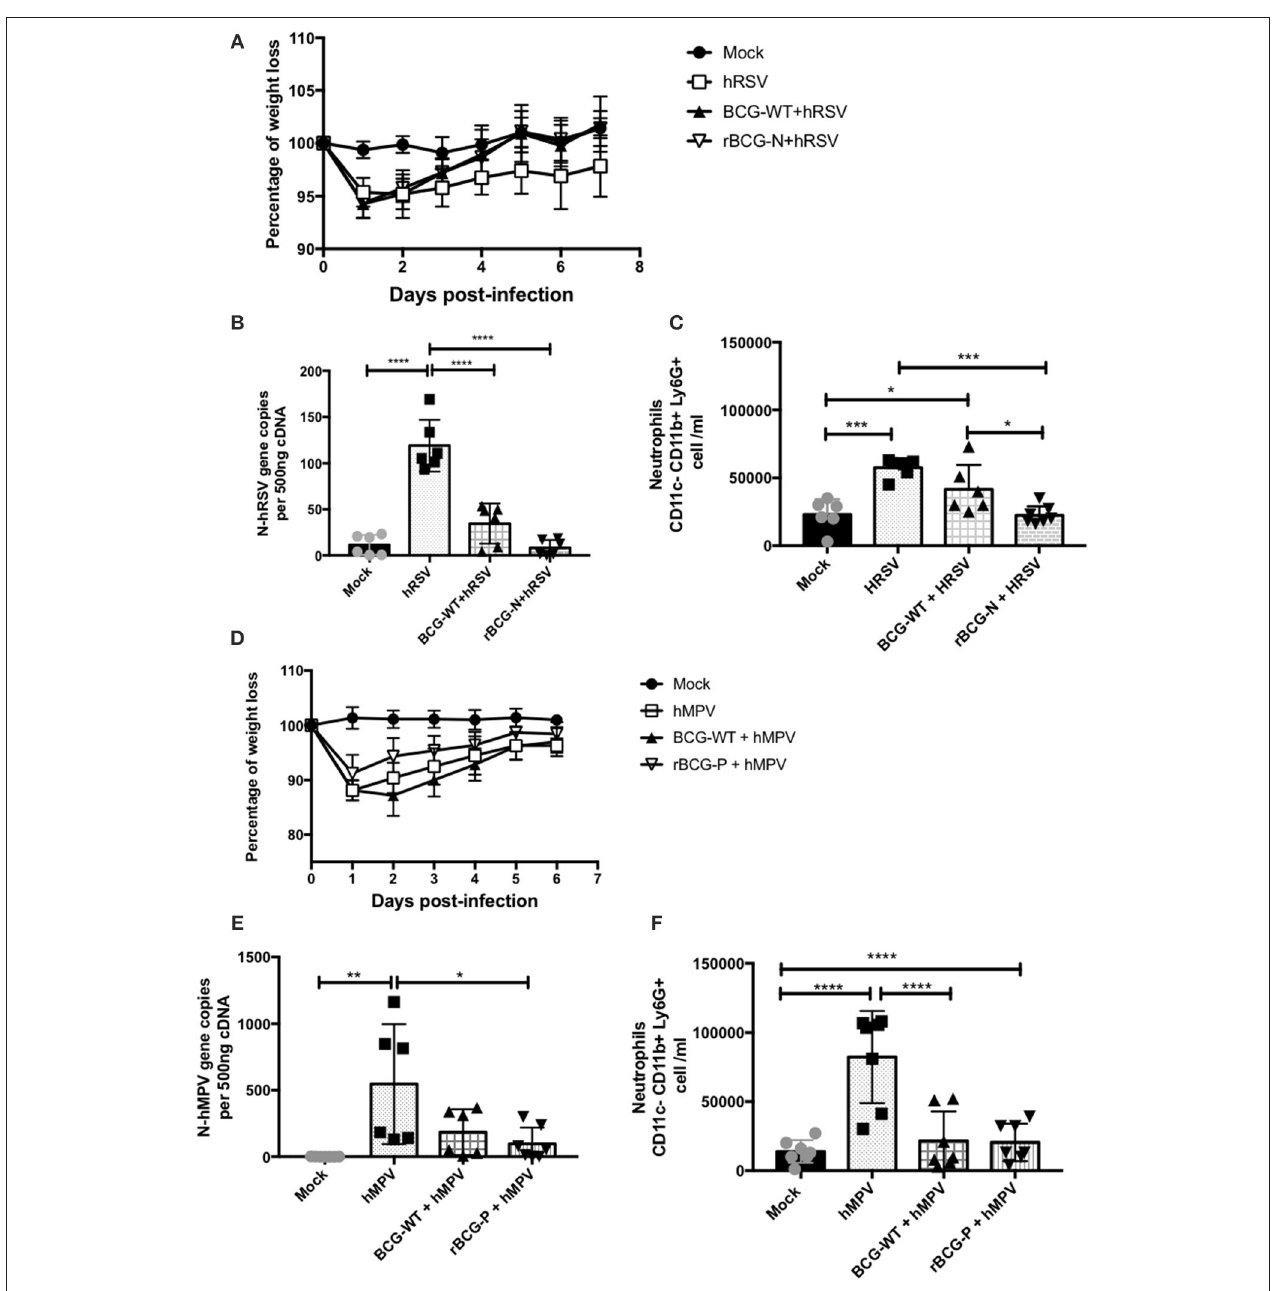
FIGURE 1 | Evaluation of infection parameters from animals infected with hRSV or hMPV . Several infection parameters were measured in the mice infected with hRSV or hMPV to corroborate that both viral infections promote the diseases. For hRSV all the parameters were measured at day 7 post-infection, for hMPV weight loss was measured for 7 days post-infection, while the neutrophils infiltrate and the viral load were measured at day 28 pi. The weight loss was measured from hRSV- (A) and hMPV-infected mice (D) . Also, the viral load was quantified for hRSV (B) and (E) hMPV. In addition, the neutrophils infiltration was measured in the hRSV- (C) and hMPV-infection (F), respectively. The bars observed in the (B,C) are accordingly: Mock-treated, hRSV-infected, Immunized with BCG-WT and infected with hRSV (BCG-WT + hRSV) and Immunized with rBCG-N and infected with hRSV (rBCG-N + hRSV). The bars observed in (E,F) are accordingly: Mock-treated, hMPV-infected, BCG-WT + hMPV, and rBCG-P + hMPV. N = 3 for each group, with two independent experiments. Differences were evaluated by a one-way ANOVA (* p < 0.05; ** p < 0.01; *** p ≤ 0.001; **** p ≤ 0.0001). The error bars represent the Standard Deviation